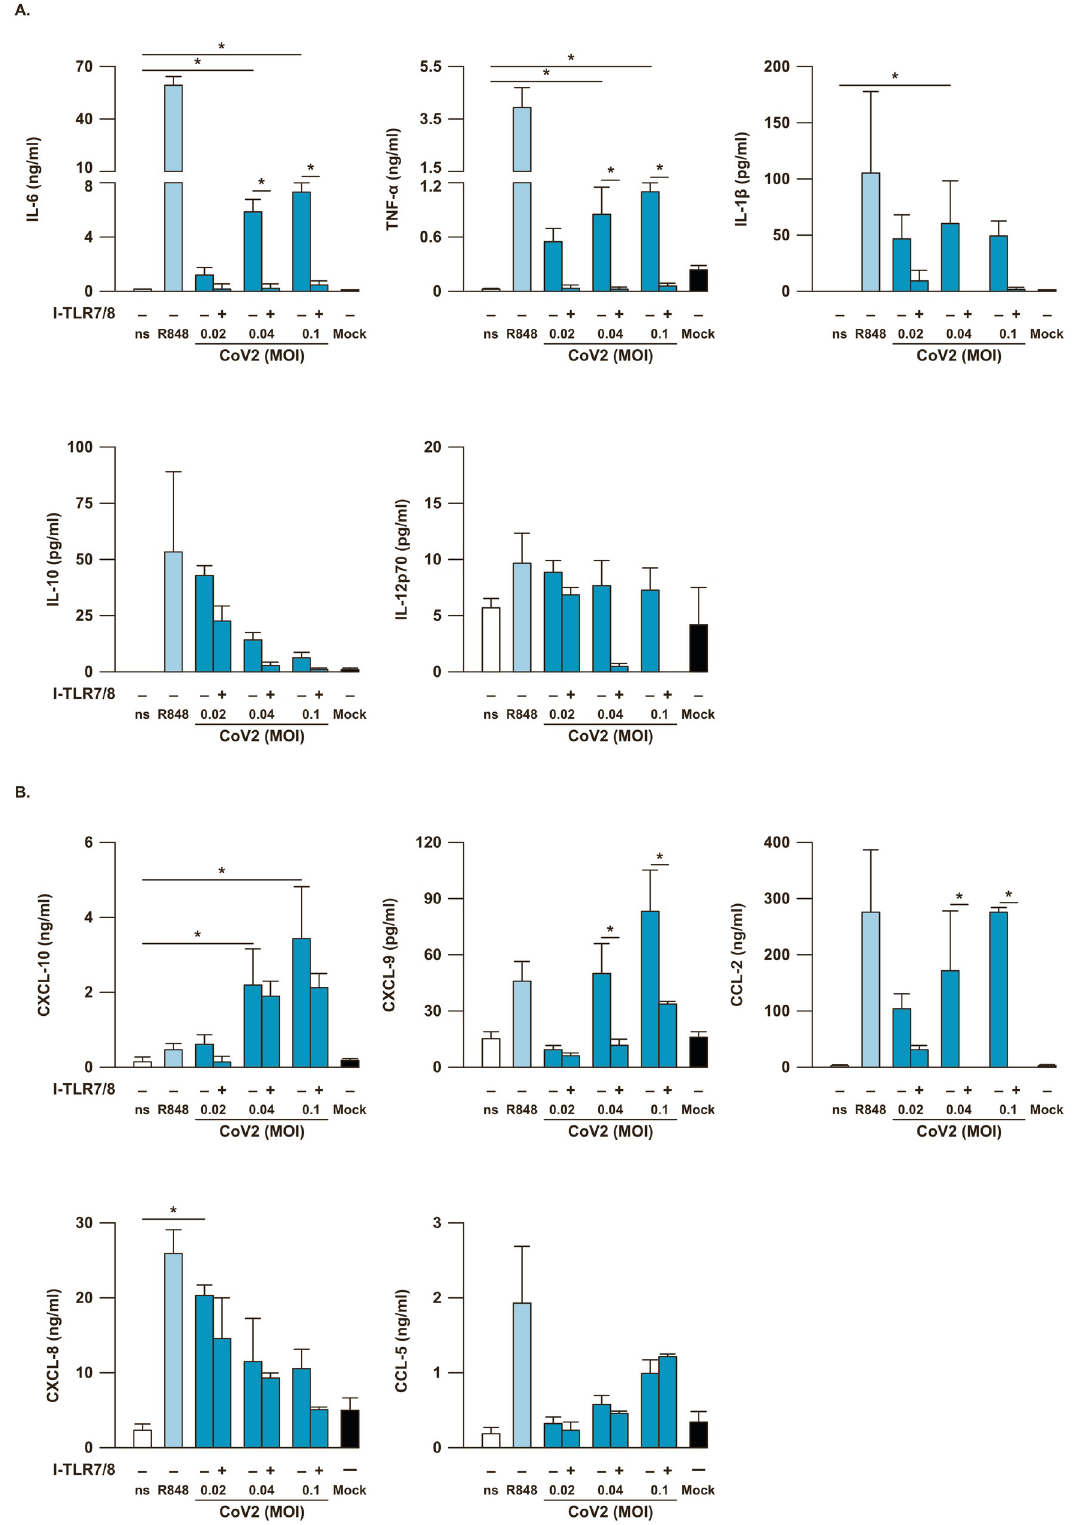
Fig 2. SARS-CoV-2 stimulation induces a TLR7/8-dependent cytokine and chemokine production in PBMC. Peripheral blood mononuclear cells (PBMC) were left untreated (not stimulated, ns) or Mock-treated as negative controls, or stimulated for 24